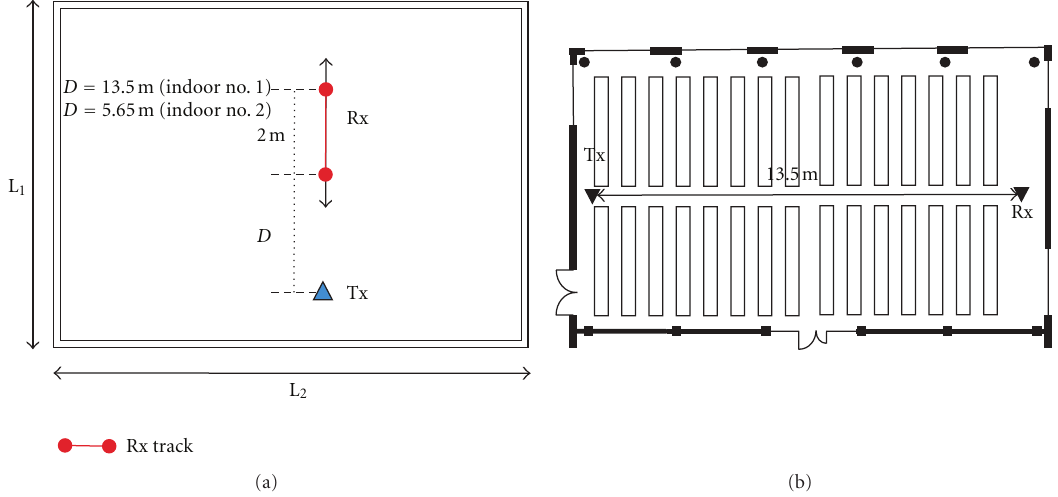
Figure 2: (a) geometry of indoor scenarios and relative placement of elements (transmitter, receiver, and linear track). (b) layout of indoor number 1 with details of furniture placement.